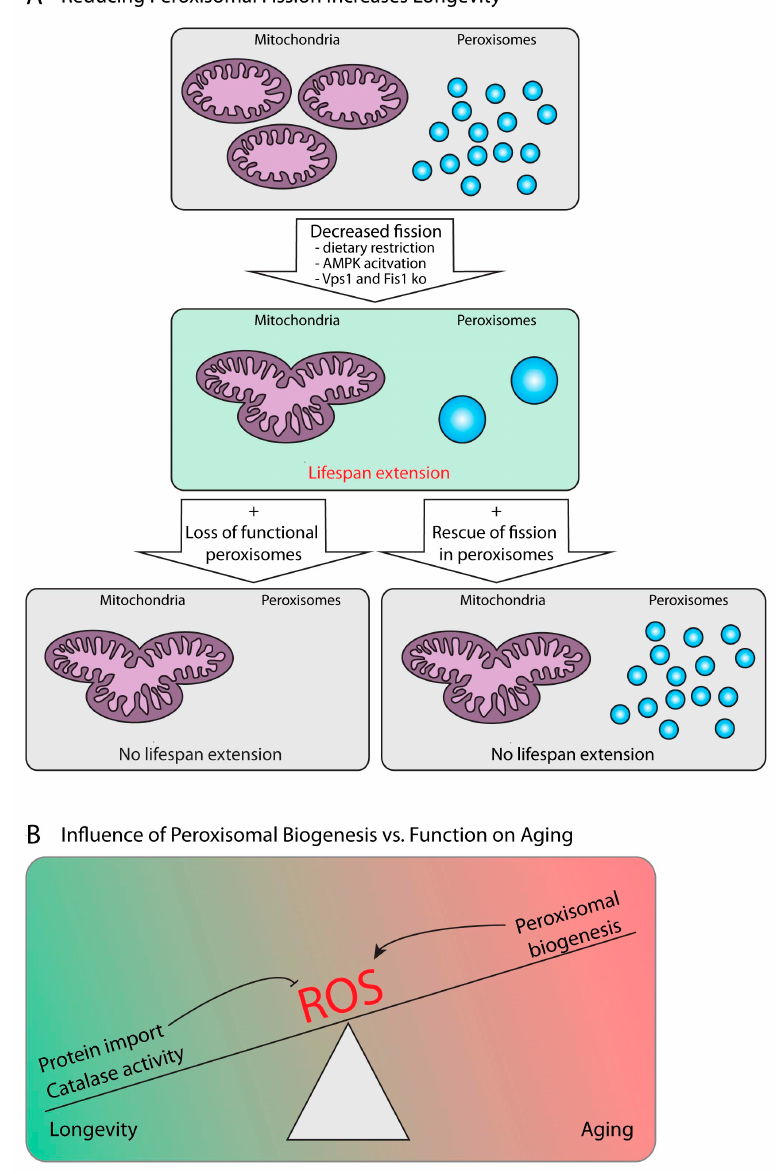
Figure 3. Peroxisomes and aging. ( A ) Mitochondria undergo cycles of fusion and fission, resulting in mitochondrial networks or fragmented mitochondria, respectively. If fission is decreased and mitochondria form a network (e.g., as a result of dietary restriction or AMPK activation, or mutation of Vps1 and Fis1 in yeast), lifespan increases. However, when the mitochondrial fission machinery is reintroduced, but targeted exclusively to peroxisomes (e.g., by overexpression of a Pex15-Fis1 fusion protein, lower right panel), or when peroxisomal functions are missing altogether (e.g., by additional mutation of the peroxisomal biogenesis factor Pex5, lower left panel), lifespan extension is lost, even though mitochondria are still forming a network. ( B ) A summary of the current understanding of the effect of peroxisome activity on aging. Peroxisomes’ effect on aging is linked to the production of reactive oxygen species (ROS): The proper activity of the peroxisomal ROS scavenging enzyme catalase is essential to promote longevity by reducing oxidative stress, while overall peroxisomal abundance (peroxisomal biogenesis) increases oxidative stress and therefore promotes